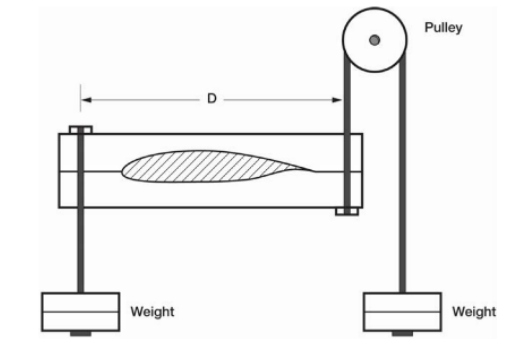
Figure 8. Loading fixture for applying